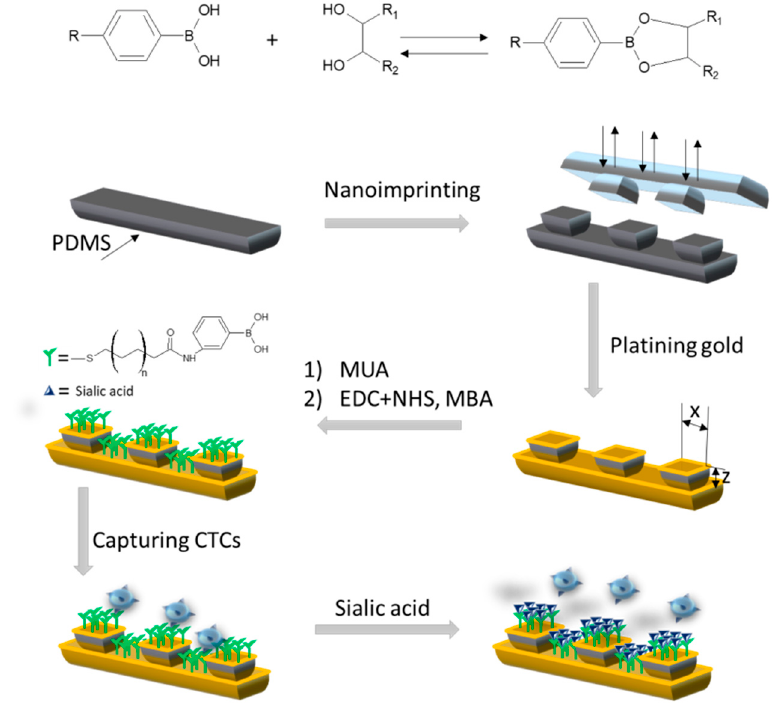
Figure 12. Scheme based on [129], showing the modification of gold-plated substrate, determination and circulating tumor cells (CTCs) release.